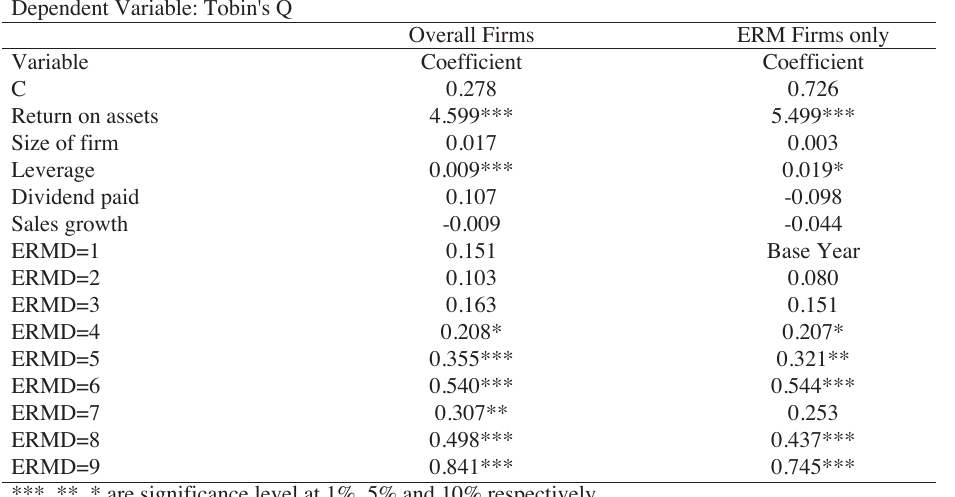
ERM Duration as a Categorical Variable and Firm